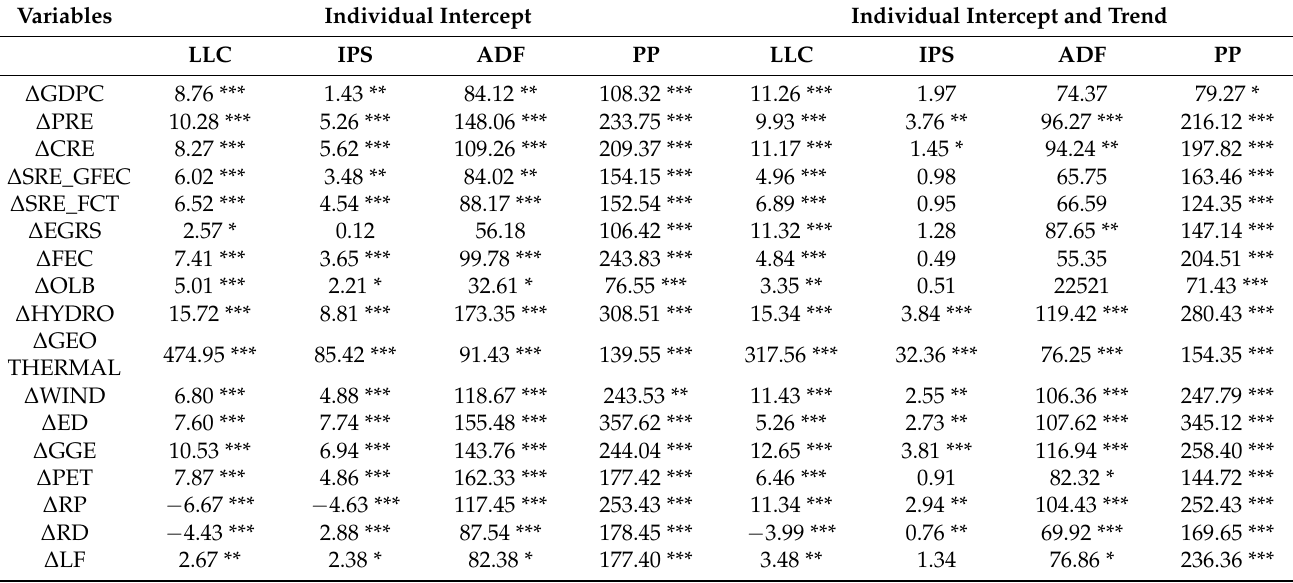
Table 4. Co-integration (First